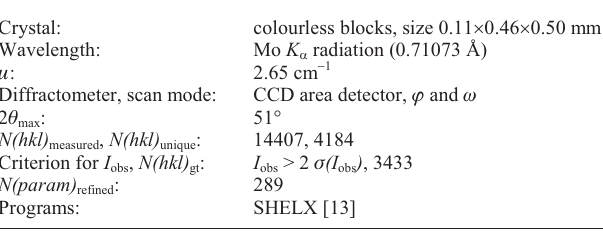
Table 2. Atomic coordinates and displacement parameters (in Å 2 )